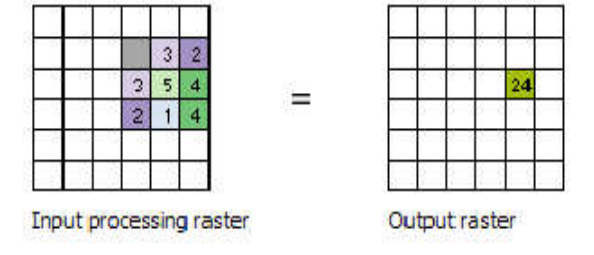
Figure 4. Focal statistic process